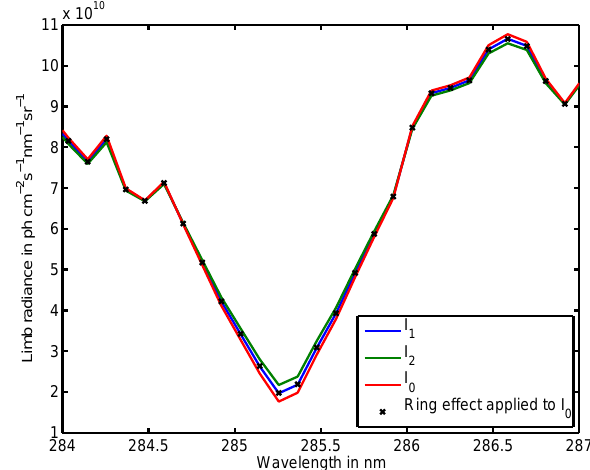
Fig. 4. Ring effect correction for the Mg 285.2nm line for a limb measurement with a tangent altitude of 53.5km. The Ring effect is simulated, using the measured spectrum I 1 (λ) , to obtain I 2 (λ) . The filling-in effect is assumed to be small and differences between the first and the second application are therefore also very small. Under this assumption, the differences are nearly the same: I 0 (λ) − I 1 (λ) ≈ I 1 (λ) − I 2 (λ) . And by adding I 1 (λ) the corrected spectrum I 0 (λ) is obtained as I 0 (λ) = 2 I 1 (λ) − I 2 (λ)